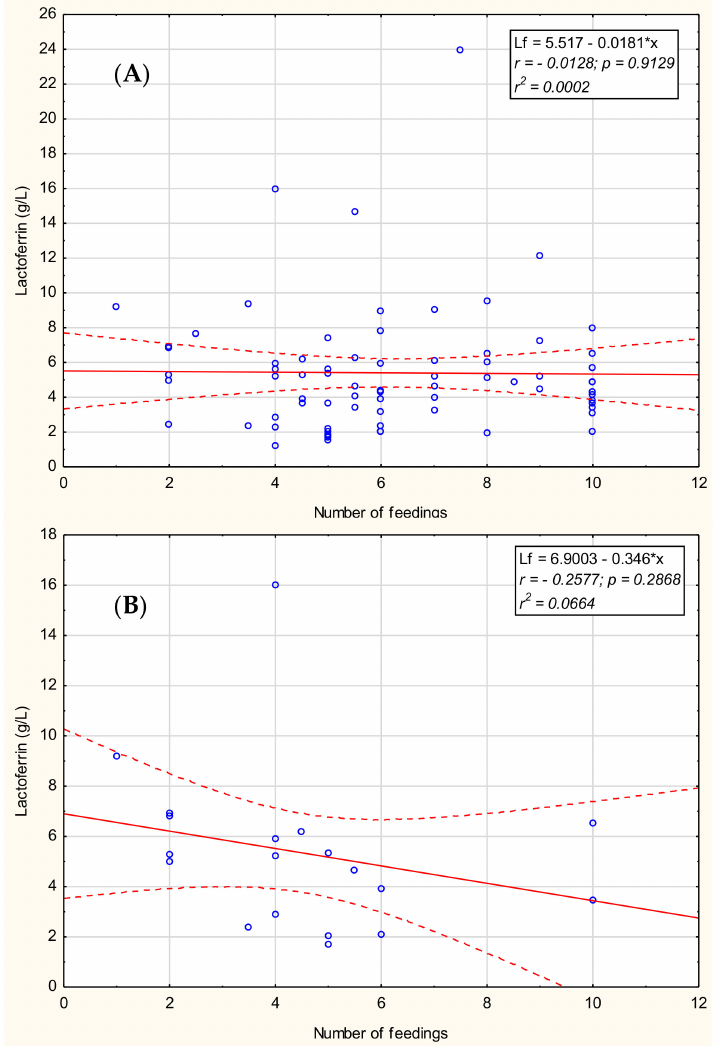
Figure 3. Relationship between the concentration of lactoferrin and the number of feedings mother’s milk ( A ) during 13–48 months of lactation, ( B ) over 24 months of lactation. A solid line indicates linear regression, and 95% confidence intervals are shown by dotted lines; blue hollow—individual samples. *: